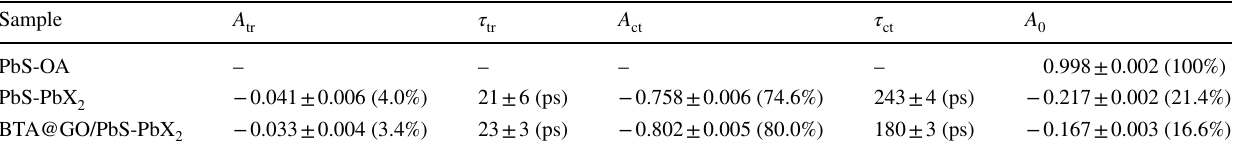
Table 1 Fitted time constants and the corresponding proportionality constants obtained from the TA decay curves of PbS-PbX 2 CQDs film and BTA@GO/PbS-PbX 2 hybrid CQDs film as shown in Fig. 3d